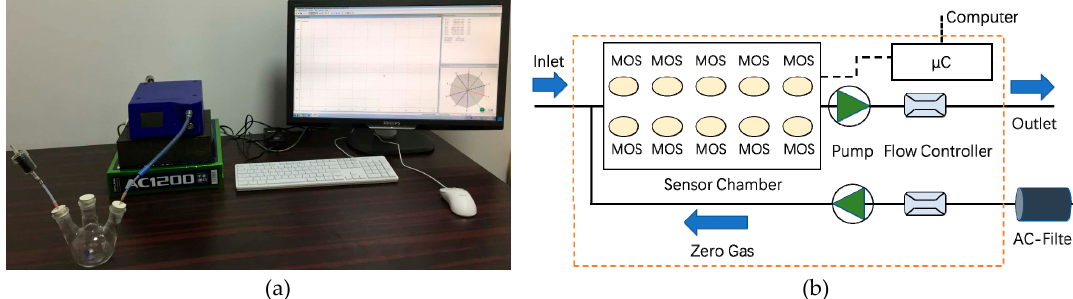
Figure 1. Experimental setup: ( a ) experimental equipment and ( b ) internal structure of PEN3 [27]. Table 1. The details of sensor array in PEN3 [27].